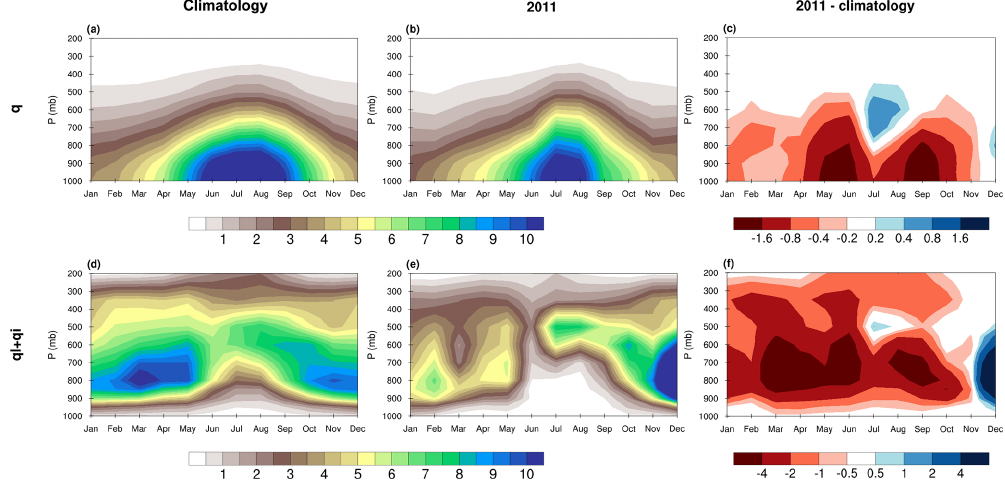
Figure 3. Hovmöller diagram of the vertical profile of the ERA-Interim specific humidity ( q ) ( a , b , c ) and specific cloud liquid ( q l ) and ice ( q i ) water ( d , e , f ) averaged over the US southern Great Plains (30–39 ◦ N and 95–105 ◦ W) for the 1979–2018 climatology ( a , d ), 2011 ( b , e ), and the difference between the climatology and 2011 ( c , f ). The unit for q , q l , and q i is grams per kilogram (gkg − 1